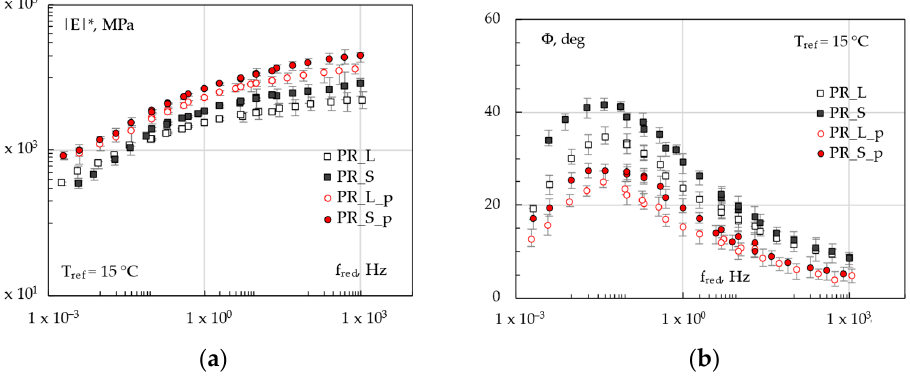
Figure 7. Master curves of mixtures at 15 °C (4PB test): |E*| ( a ) and Φ ( b ).